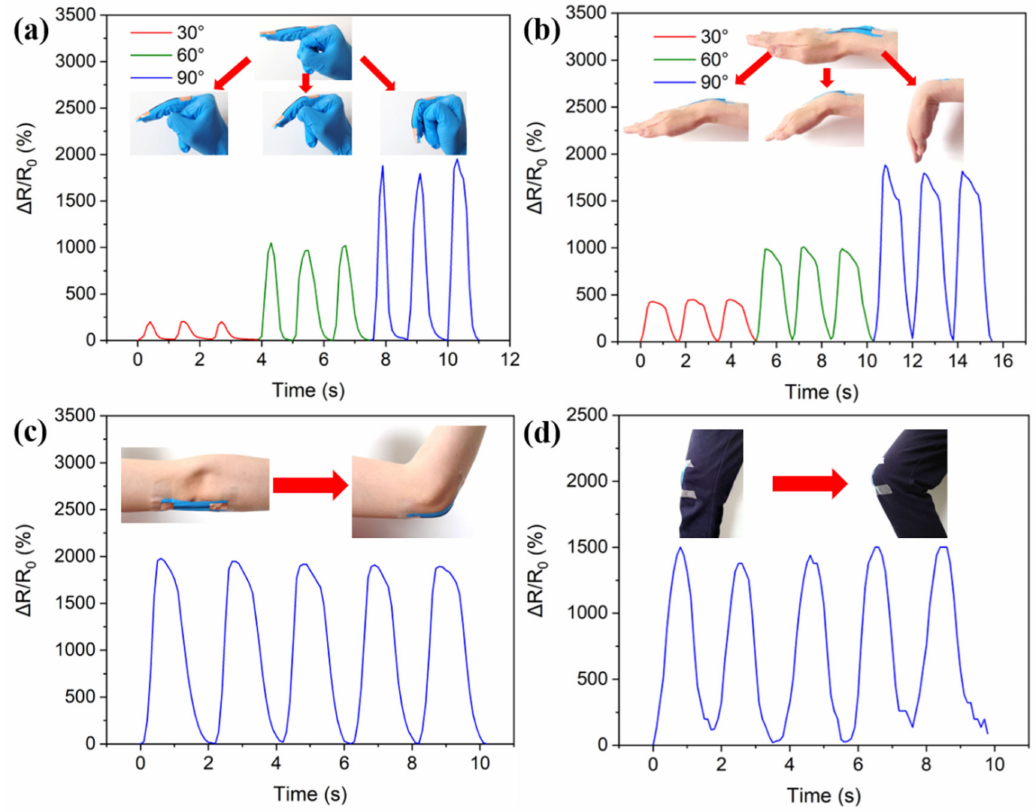
Figure 9. PDA@SEBS/MWCNTs yarn used to monitor human motions. ( a ) finger bending. ( b ) wrist bending. ( c ) elbow bending. ( d ) knee